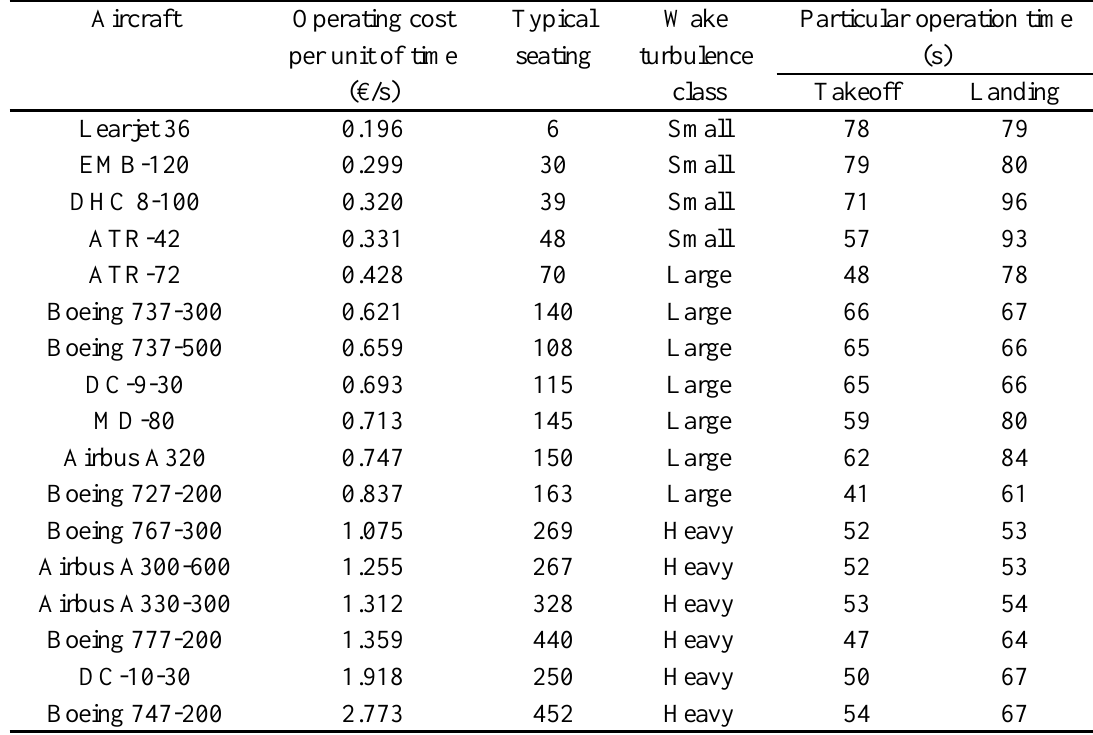
Table 1. Typical operational characteristics of different